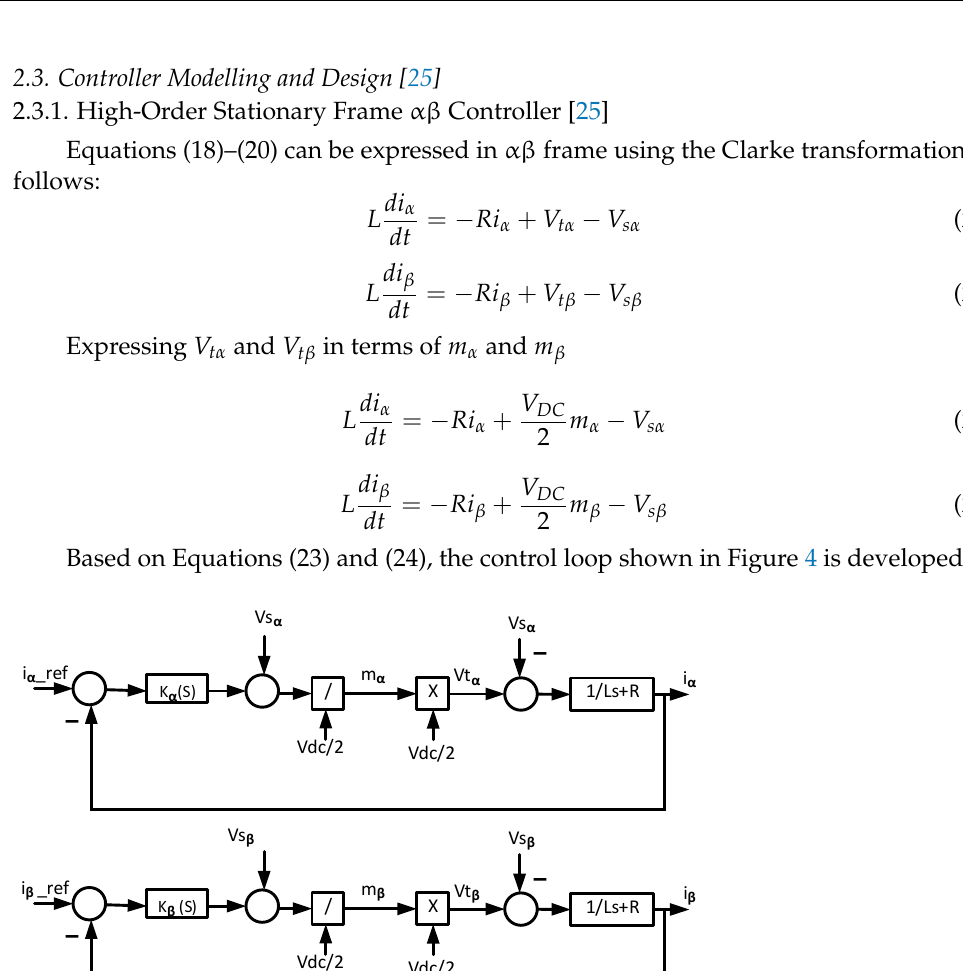
Figure 4. Current control loop in αβ frame.